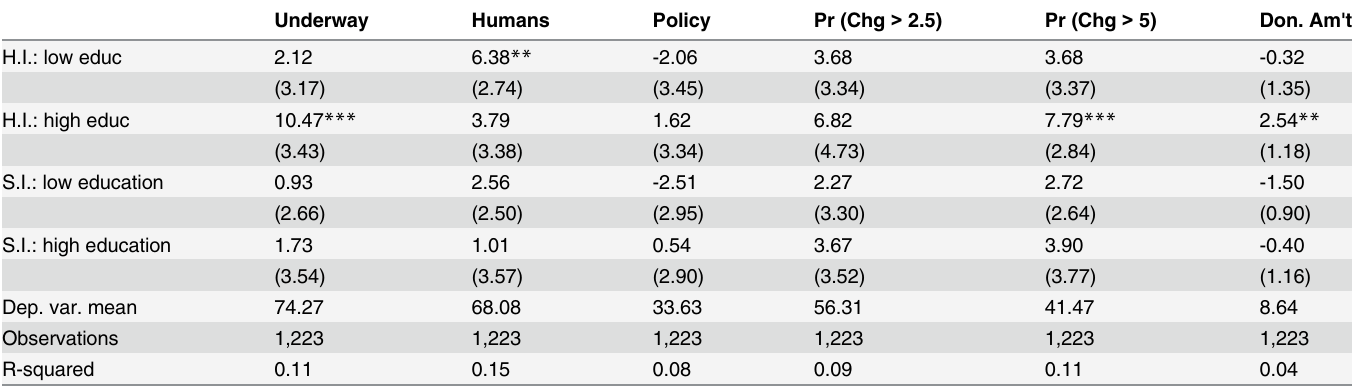
Table 4. Short-run effects of information by education.